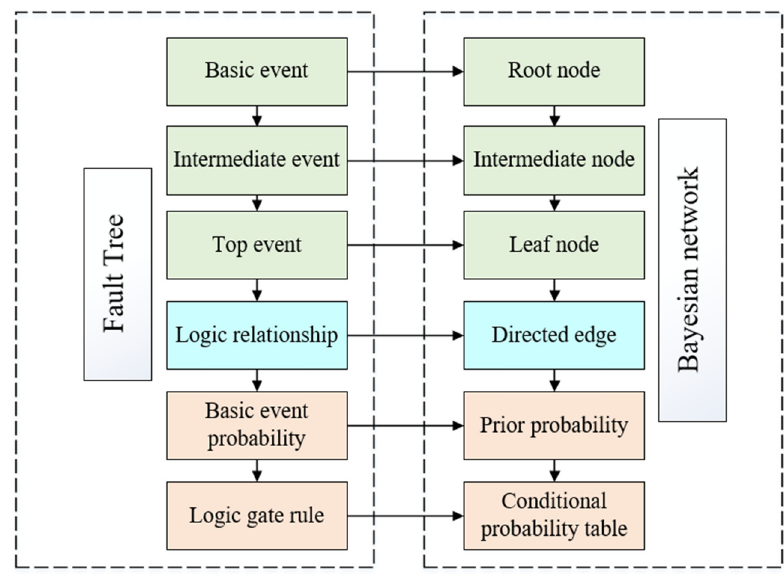
Figure 3. Mapping rules from fault tree to Bayesian network.